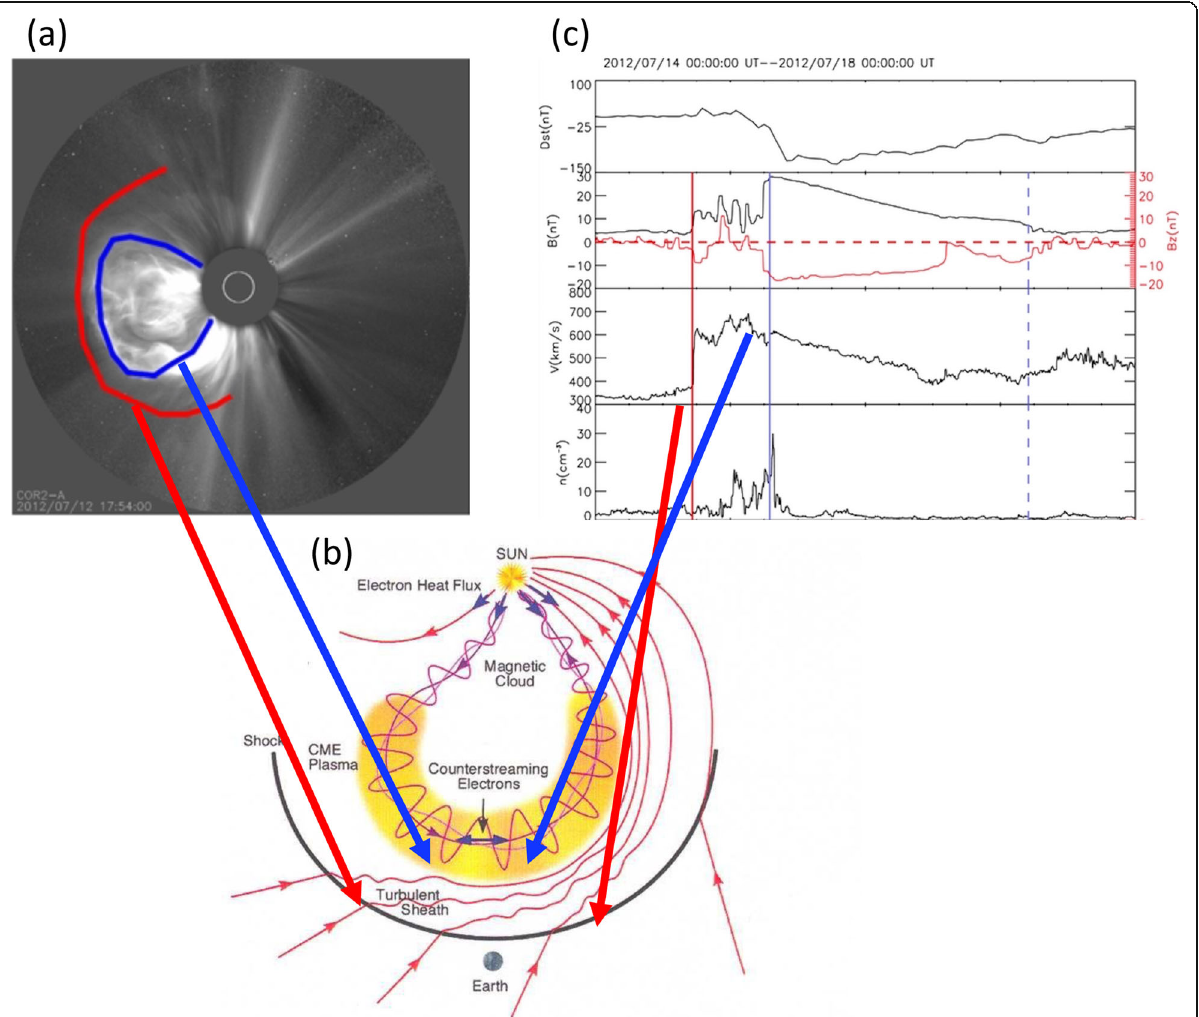
Fig. 1 A schematic of a CME and its interplanetary counterpart ICME. Top left: the CME image in white light near the Sun (an event on July 12, 2012, adopted from Hess and Zhang (2014). The red and blue curves outline the shock front and CME ejecta front, respectively. The Sun is indicated by the white circle in the center. Top right: the in situ data of the resulting ICME near the Earth (adopted from Hess and Zhang 2014). From top to bottom, the five panels show the Dst index, solar wind magnetic field, velocity, and density. The vertical red line indicates the arrival time of the shock, and two vertical blue lines indicate the beginning and ending time of the CME ejecta. Bottom: A schematic of CME/ICME illustrates its geometry and internal components including the shock front, turbulent sheath and draped ambient magnetic field, twisted magnetic field in the CME ejecta and electron heat flux along magnetic fields. (adopted from Zurbuchen and Richardson